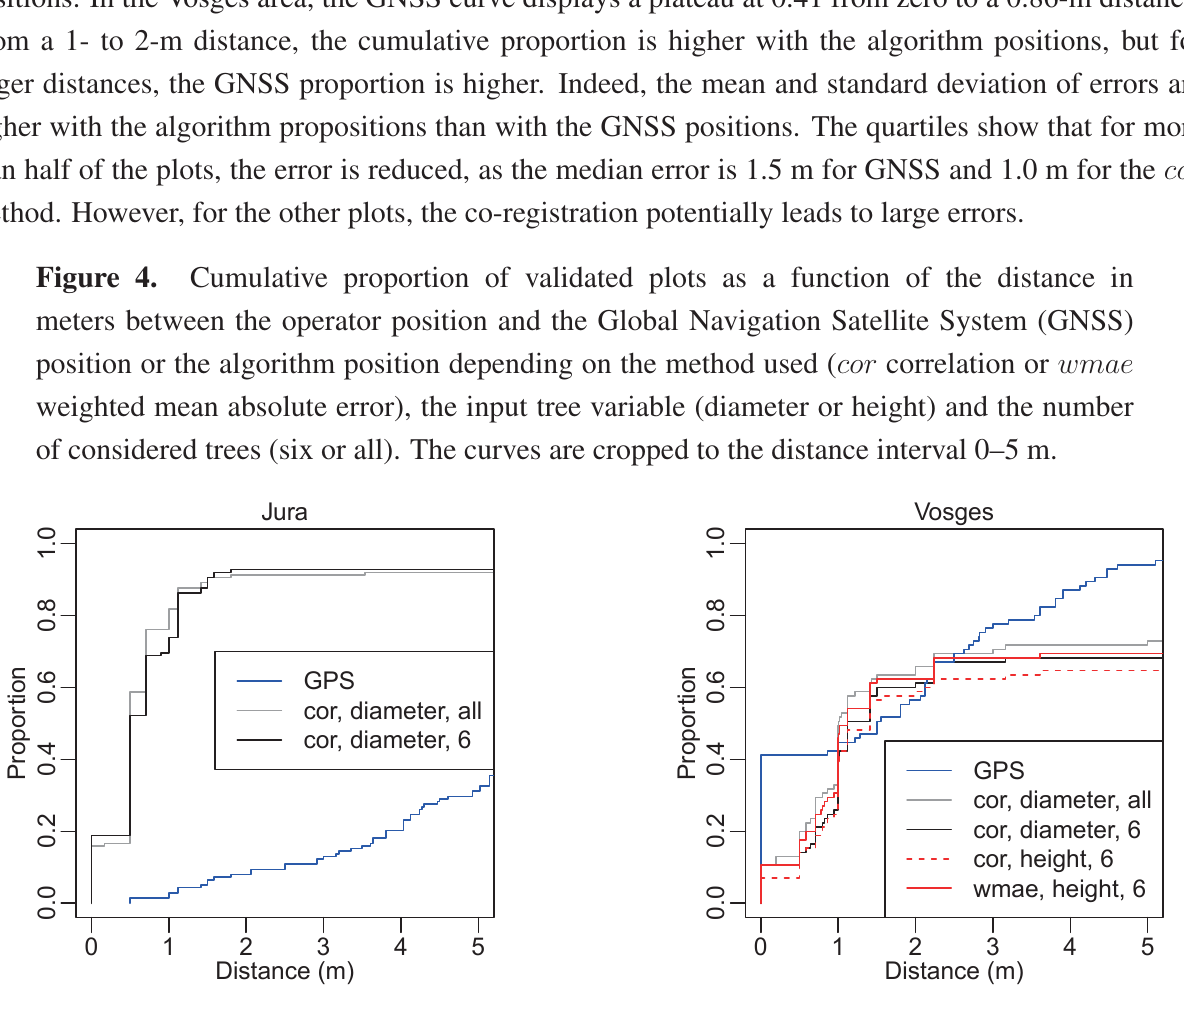
Table 2. Statistics on the distance in meters between the GNSS and operator positions and between the operator positions and various algorithm propositions for the validated plots. On the first line is the mean ± standard deviation; on the second line are the quartiles. GNSS cor , Diameter, All cor , Diameter, 6 cor , Height, All wmae , Height, All Jura Vosges 0 , 1 . 5 , 2 .